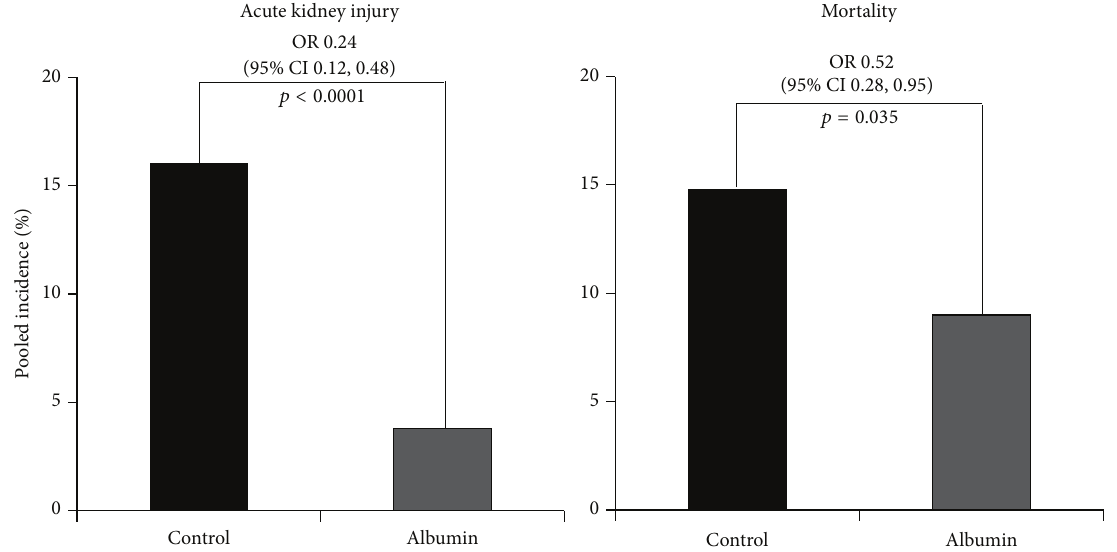
Figure 1: Reduction in the frequency of occurrence of acute kidney injury and death in volume therapy with hyperoncotic human albumin (20% or 25%) compared to control treatment with hypooncotic solution (crystalloids, 4% or 5% human albumin solution) or no infusion. OR, odds ratio; CI, confidence interval. Data are from Wiedermann et al. [43].